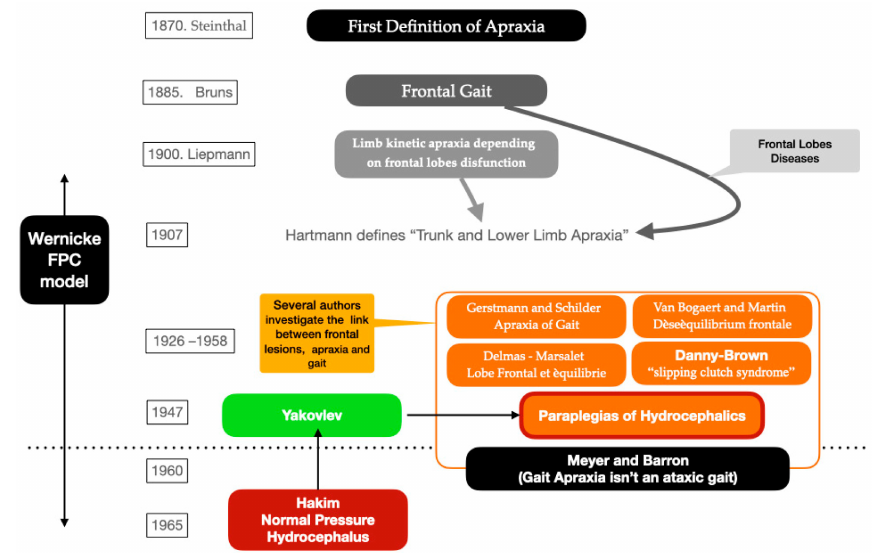
Figure 2. The historical evolution of the concept of gait apraxia in frontal